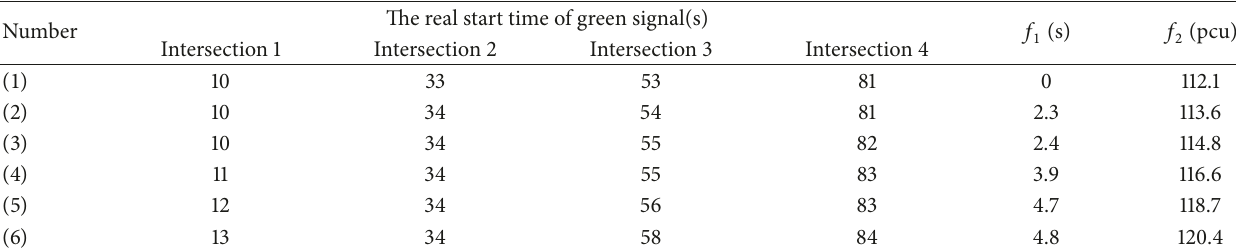
Table 1: The Pareto solution set of of EV when 𝑡 0 is 9 o’clock.